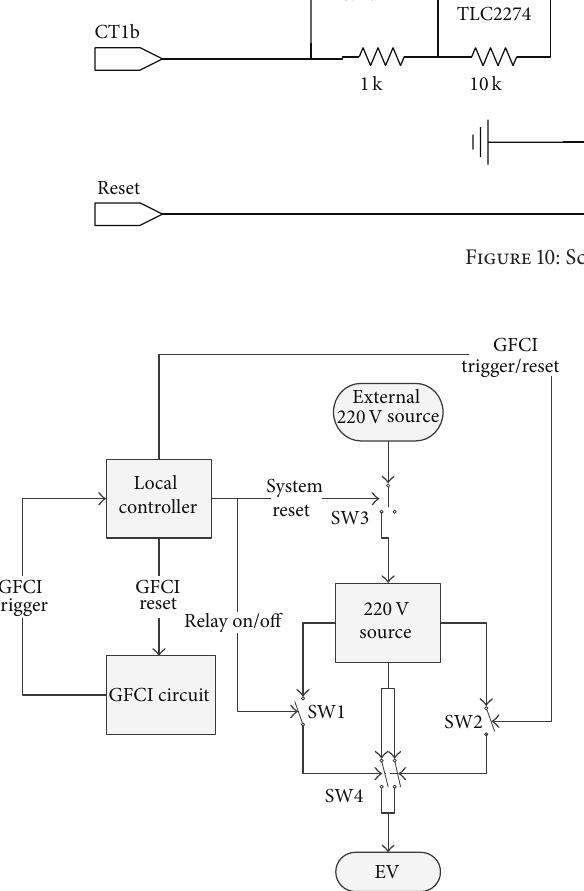
Figure 11: Schematic of safety control for the relay.